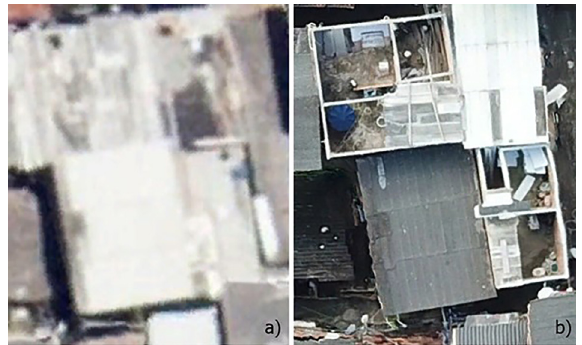
visible.Fig. 8. Google Earth a and drone b. Detailing the spacing between buildings, and roof cover